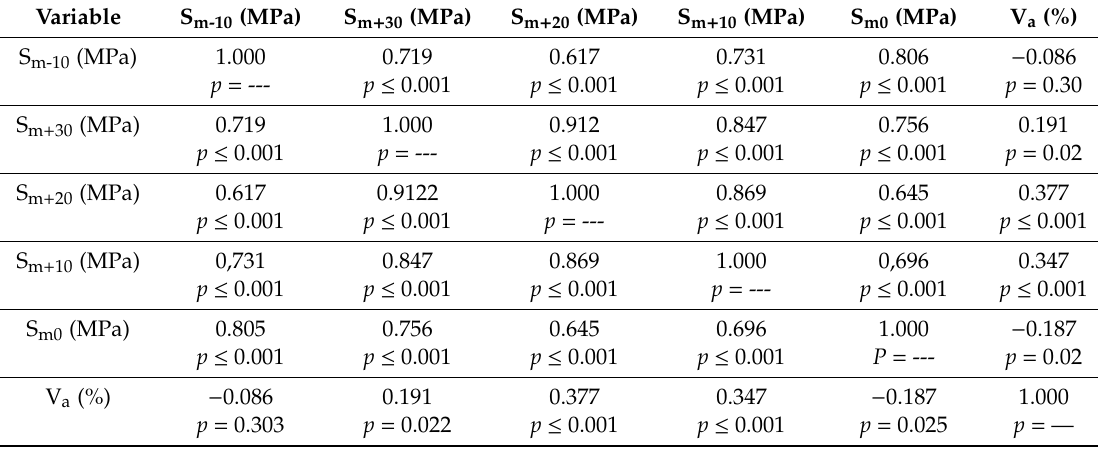
Table 7. Correlations between AC 8 S